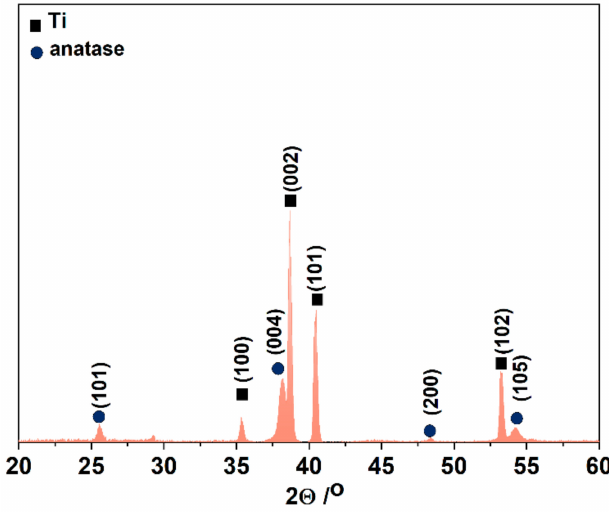
Figure 2. XRD pattern of anodic TiO 2 annealed at 400 ◦ C for 2 h in